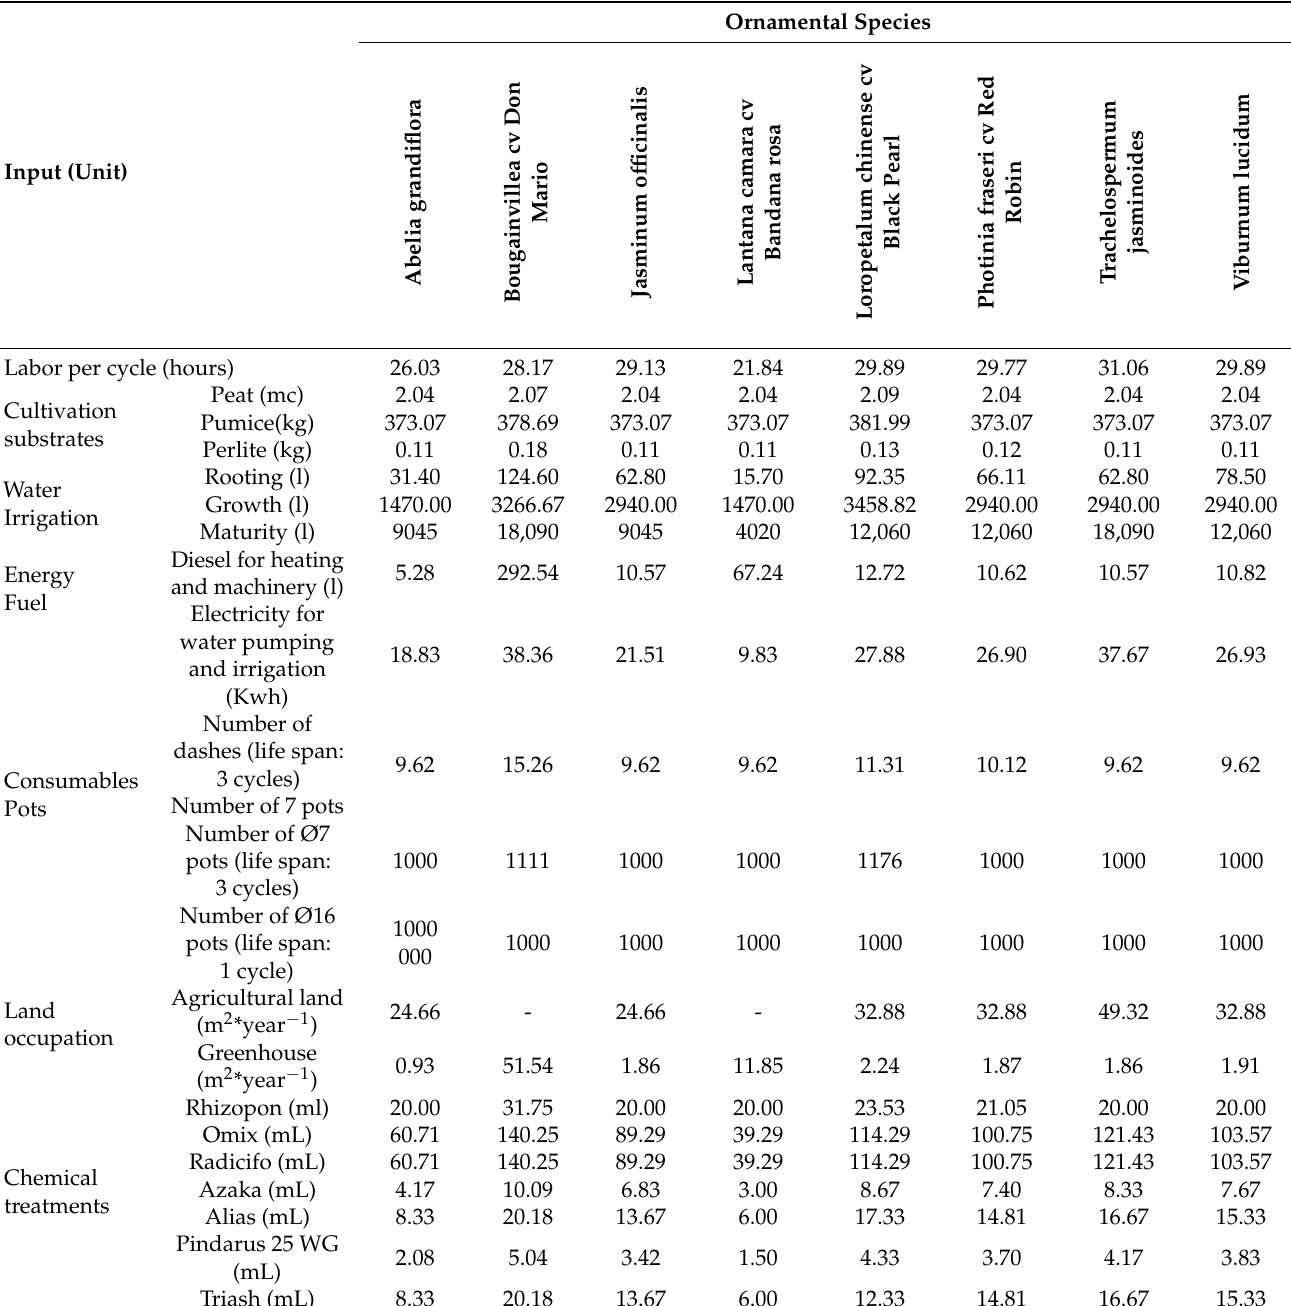
Table A2. Types of inputs used under NSM ornamental production